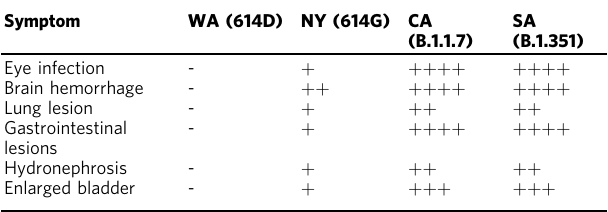
*K18-hACE2 mice of both sexes (~1:1 ratio) were infected intranasally with USA-WA1/2020 (WA) of lineage A bearing 614D at 10 4 TCID 50 /mouse, New York-PV09158/2020 (NY) of lineage B.1.3 bearing 614G at 10 3 TCID 50 /mouse, USA/CA_CDC_5574/2020 (CA) of lineage B.1.1.7 at 10 2 TCID 50 /mouse or hCoV-19/South Africa/KRISP-EC-K005321/2020 (SA) of lineageB.1.351 at10 2 TCID 50 /mouse,respectively.Frequenciesof symptomslistedwerescored. − , not observed; + , <10%; ++ , 10 – 20%; +++ , 30 – 40%; ++++ , >50 – 60% of infected